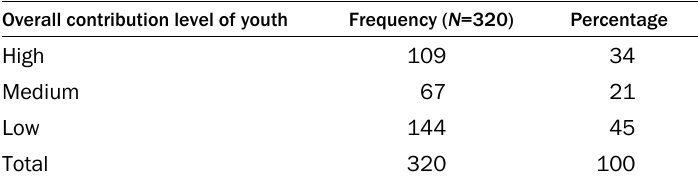
Table 8. Youth Contribution to Agro-Economic Transformation Overall contribution level of